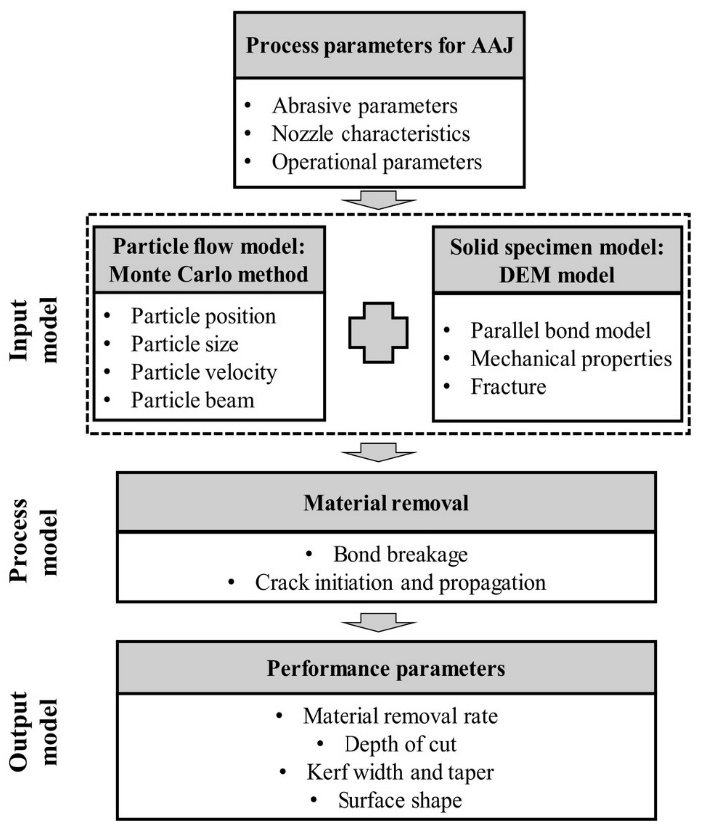
Figure 31. The flowchart of the modeling framework of the MC method coupled with the DEM for multi-particle impact erosion [185].